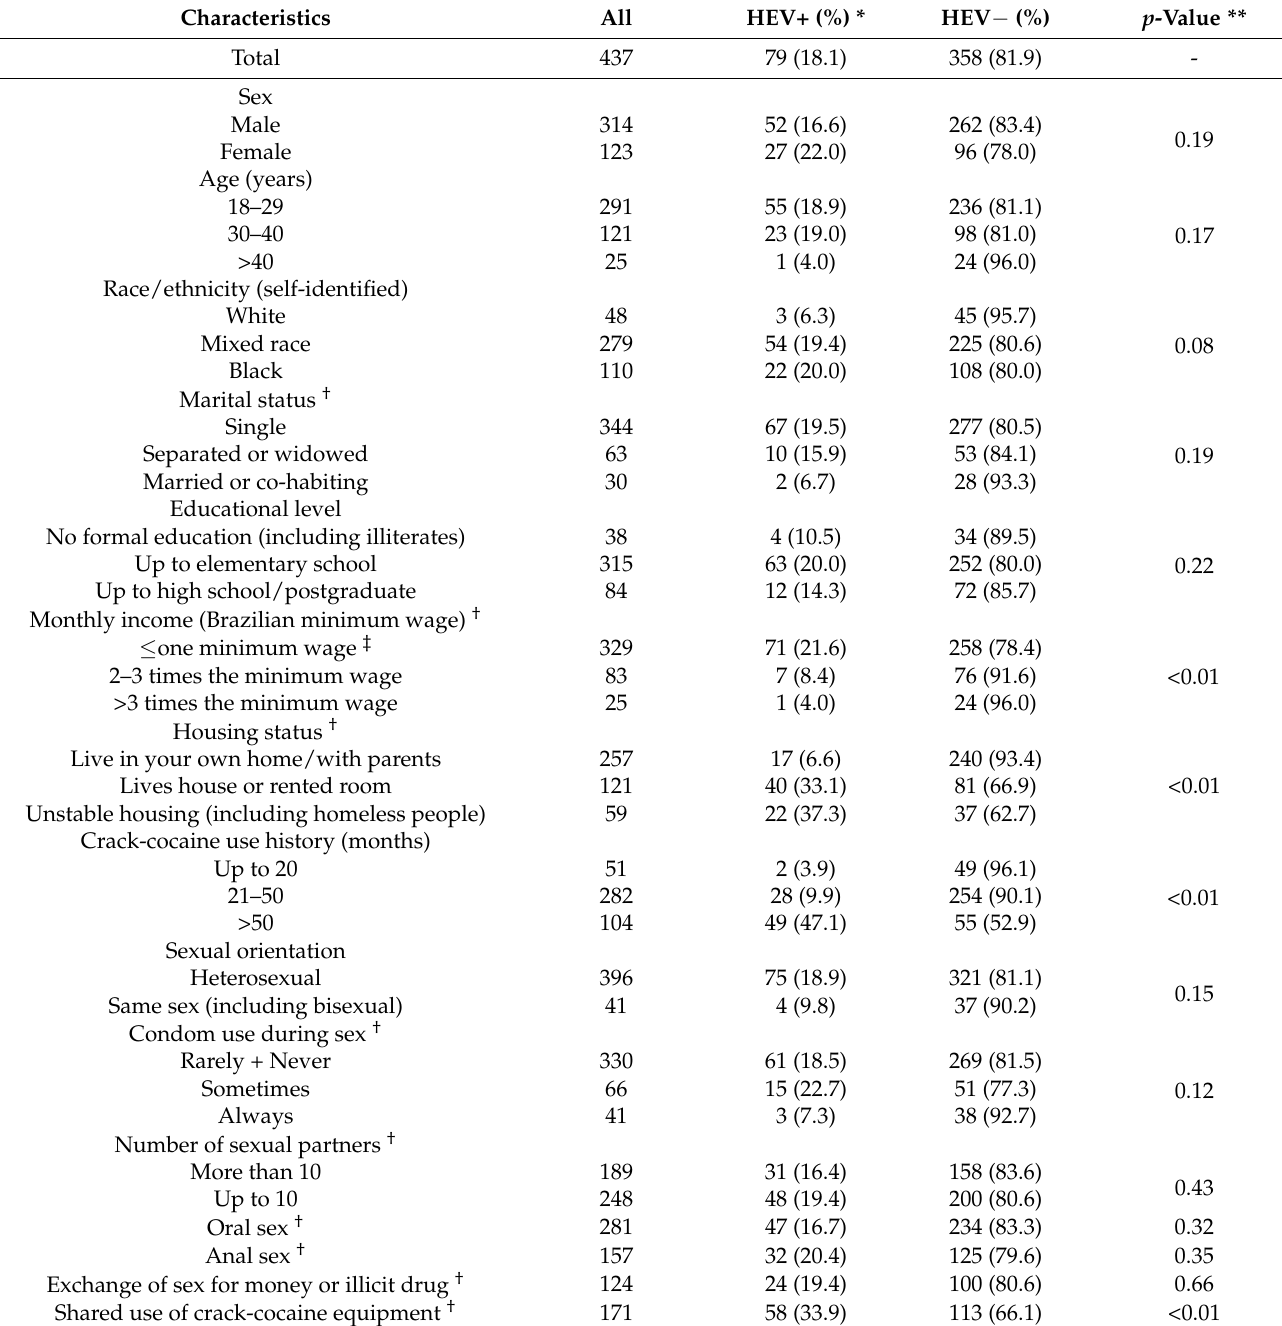
Table 1. Demographic, socioeconomic and behavioral characteristics of people who use crack-cocaine related to hepatitis E virus exposure in a remote region of northern